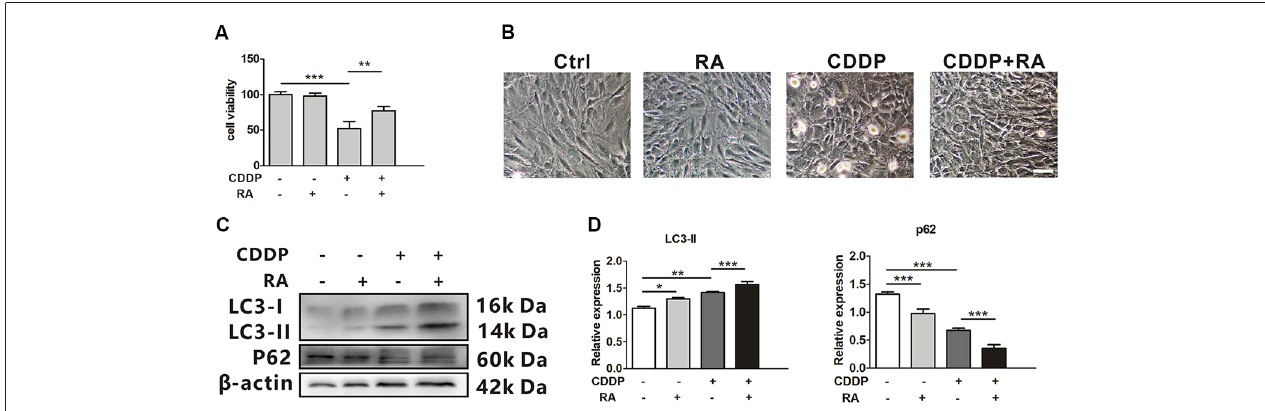
FIGURE 2 | Rapamycin promotes HEI-OC1 cell survival after cisplatin-induced damage. (A) The CCK8 assay was performed to examine cell viability of HEI-OC1 cells following CDDP (20 µ M) exposure for 24 h with or without RA (0.5 µ M; n = 3 individual experiments). (B) The image of HEI-OC1 cells following CDDP (20 µ M) exposure for 24 h with or without RA (0.5 µ M; n = 3 individual experiments). (C,D) Western blots and densitometry analysis for autophagy marker LC3-II and p62 in CDDP (20 µ M) exposure for 24 h with or without RA (0.5 µ M; n = 3). Data represent the mean ± SEM. ∗ p < 0.05, ∗∗ p < 0.01, ∗∗∗ p < 0.001. CDDP, cisplatin; RA, rapamycin.